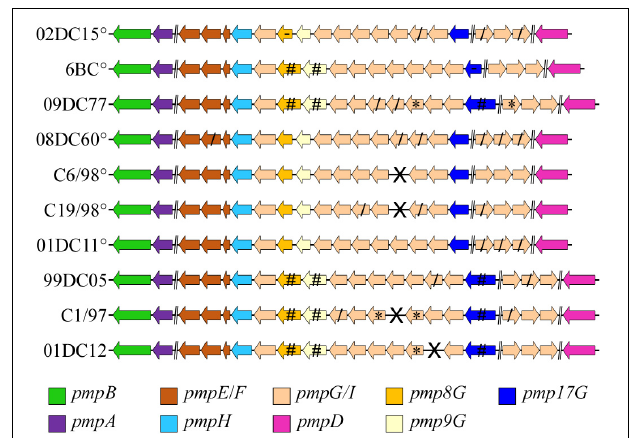
FIGURE 2 | Genomic organization of all identified pmp genes of C. psittaci strains in the study. ◦ : C. psittaci strains belonging to genotype A. Brake ( // ) represents a genomic region bigger than 5000 bp (implemented from Van Lent et al., 2016a). X: missing gene, * : Partial sequence, due to a genome sequence or assembly gap, /: truncated gene product. Pmp8G, pmp9G, and pmp17G genes (highlighted in dark yellow, light yellow, and blue, respectively) represent the most diverse genes according to their size among the different strains. # : genes 350, 680, and 1200 bp bigger than the respective pmp8G, pmp9G, and pmp17G from 02DC15, used as reference strain. -: The shortest pmp8G and pmp17G genes among the respective genes in all